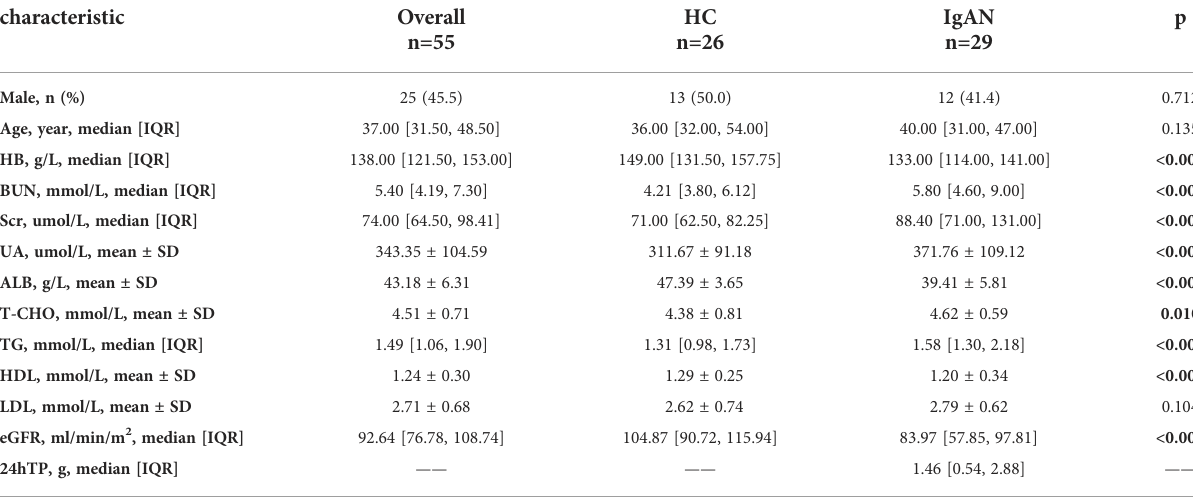
TABLE 2 Comparison of baseline characteristics of IgAN and HC groups in untargeted Metabolomics analysis.